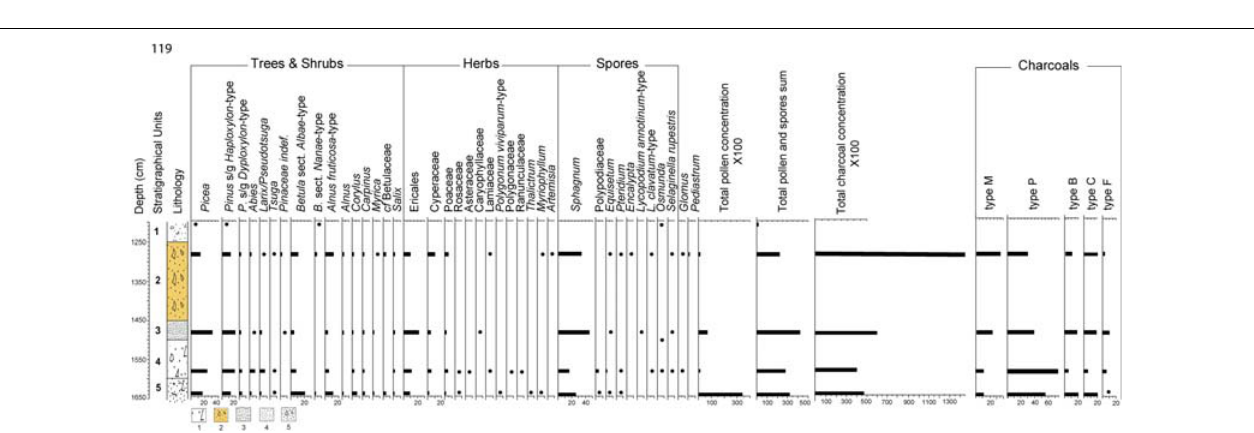
FIGURE 3 | Percentage pollen, spore, and non-pollen-palynomorph diagram of site 118 (for location see Figure 1B ). 1 – grayish clay (11.8–12.3 m) and brownish fine sandy loam (10.5–11.8 m); 2 – grayish-greenish compacted pebble bed with sand and fine sandy loam; 3 – yellowish-greenish sandy pebble bed with boulders at the base; 4 – yellowish-brown sand with few small pebbles and some lignite lenses between 6.0–6.5 m; 5 – yellowish-brownish pebble bed with medium to -coarse sand and numerous remains of coniferous trees; 6 – sand and fine sandy loam; 7 – brown-yellowish pebble bed with coarse sand.